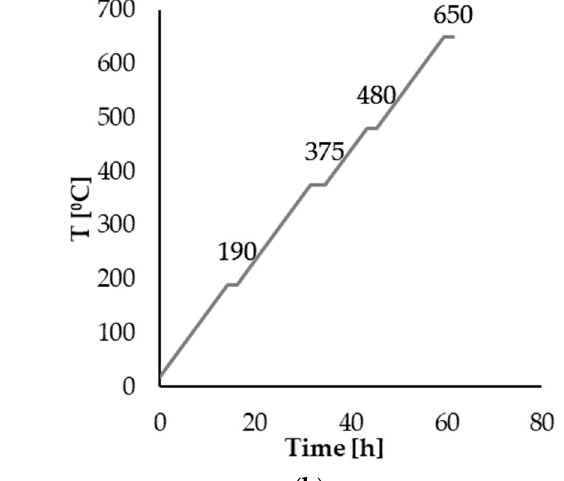
( b ) Figure 7. ( a ) Diameter dimension evolution. ( b ) SEM images of green, brown, and sintered T1 sam- ples, respectively.